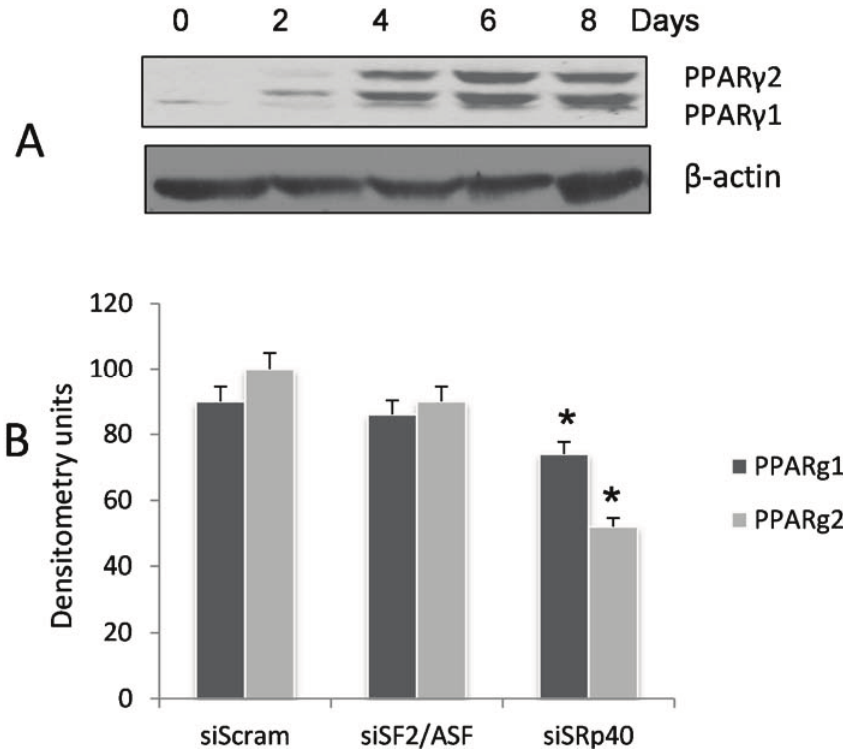
Figure 1. The splicing of PPAR(cid:2)1 and (cid:2)2 in differentiating 3T3-L1 adipocytes is decreased with siRNA to SRp40. ( A ) Cell lysates were collected on days as indicated, and subjected to WB using anti-PPAR(cid:2). (cid:3)-actin was probed on the same blot as a control. The experiment was repeated three times with similar results; ( B ) Cells were treated with siRNA as